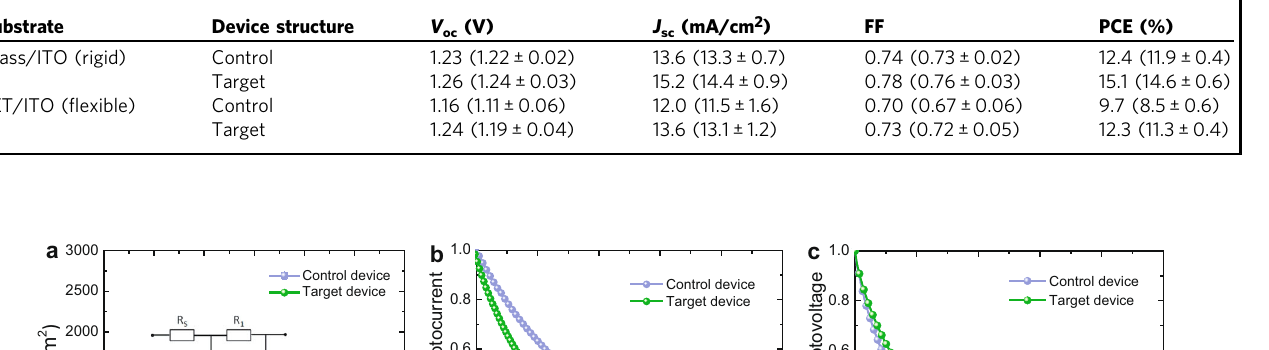
Table 1 Statistics of CsPbI 3 QD solar cell performance with varied QD absorber layers based on 24 devices.